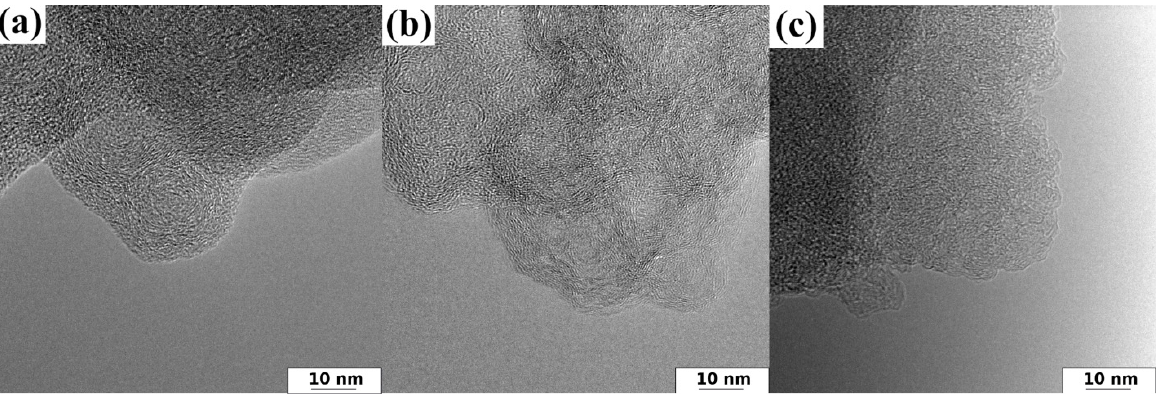
Figure 1. HRTEM images of representative samples for all investigated series of the obtained mate-